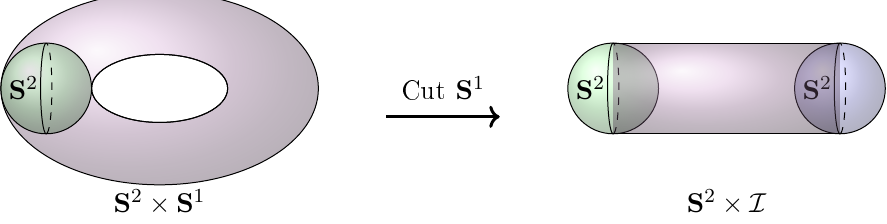
Figure 25 . Normalized density matrix (cid:26) is obtained by cutting the Chern-Simons path integral b on S 2 (cid:2) S 1 along a (cid:12)xed Euclidean time slice gives us the path integral over S 2 (cid:2) I , where I is an interval obtained by cutting the euclidean time circle.